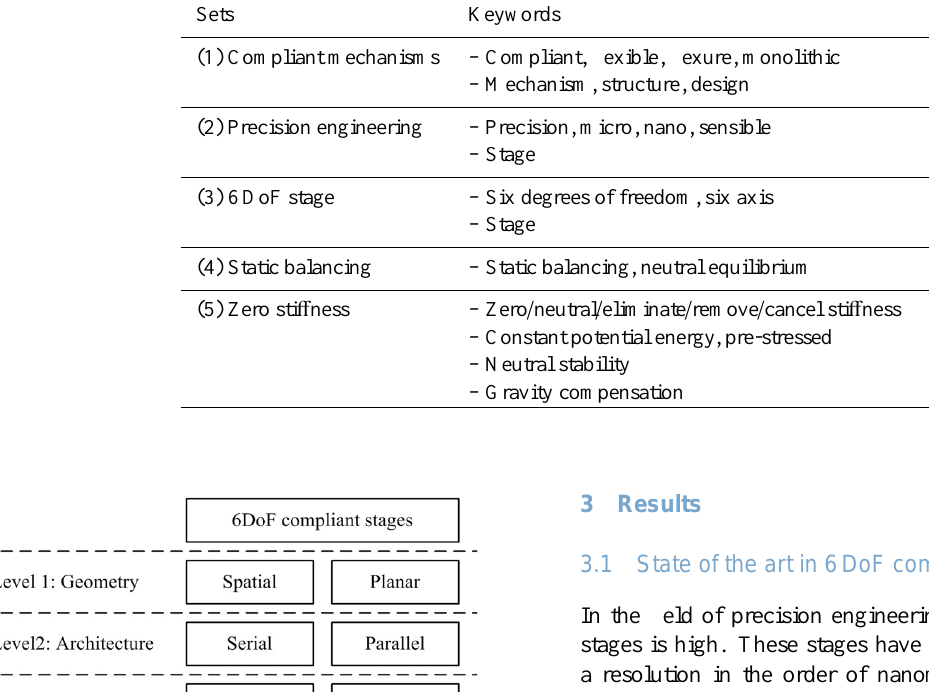
Table 1. Overview of the sets of keywords used in SCOPUS (1–5) and Espacenet (1, 3, 4, 5). Sets